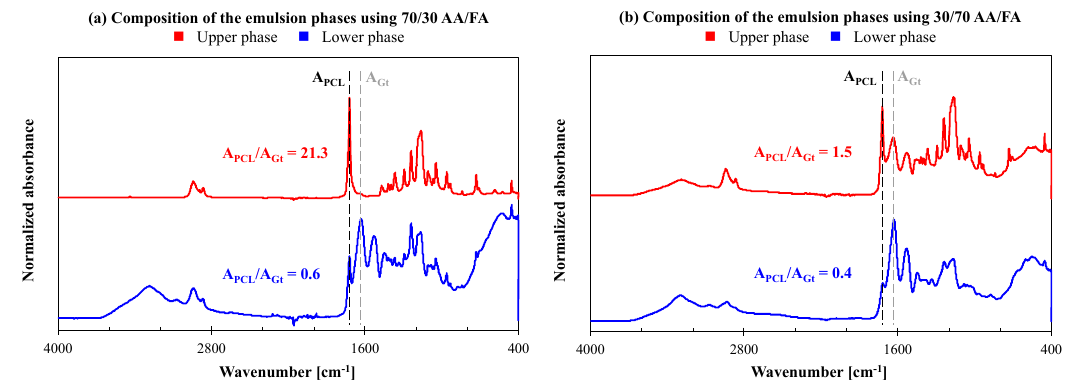
Figure 4. Normalized Attenuated Total Reflectance-Fourier-transform infrared spectroscopy (ATR-FTIR) spectra of films obtained by solution casting the upper (red) or lower (blue) phase, representing the continuous and dispersed phase respectively, of a PCL/Gt emulsion in ( a ) 70/30 AA/FA or ( b ) 30/70 AA/FA left at rest.